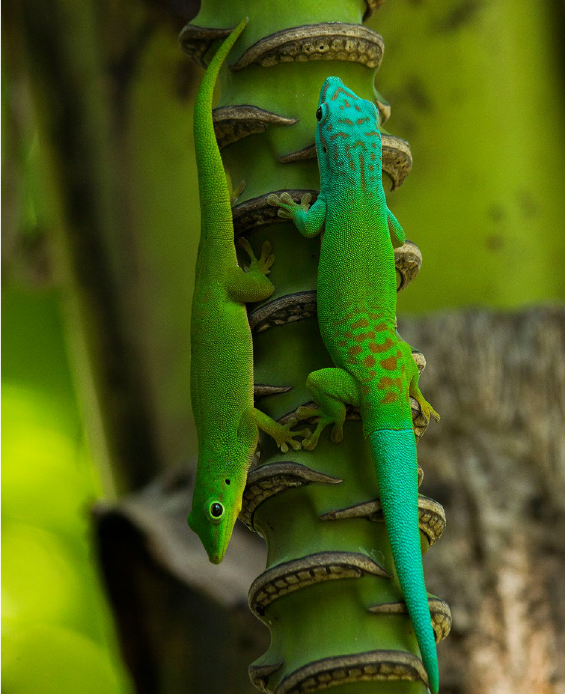
Figure 1. Female (evenly green) and male (turquoise head and tail) individuals of the Andaman day gecko ( Phelsuma andamanensis ) from the North Andaman Island. Image from Sanjay Prasad used with